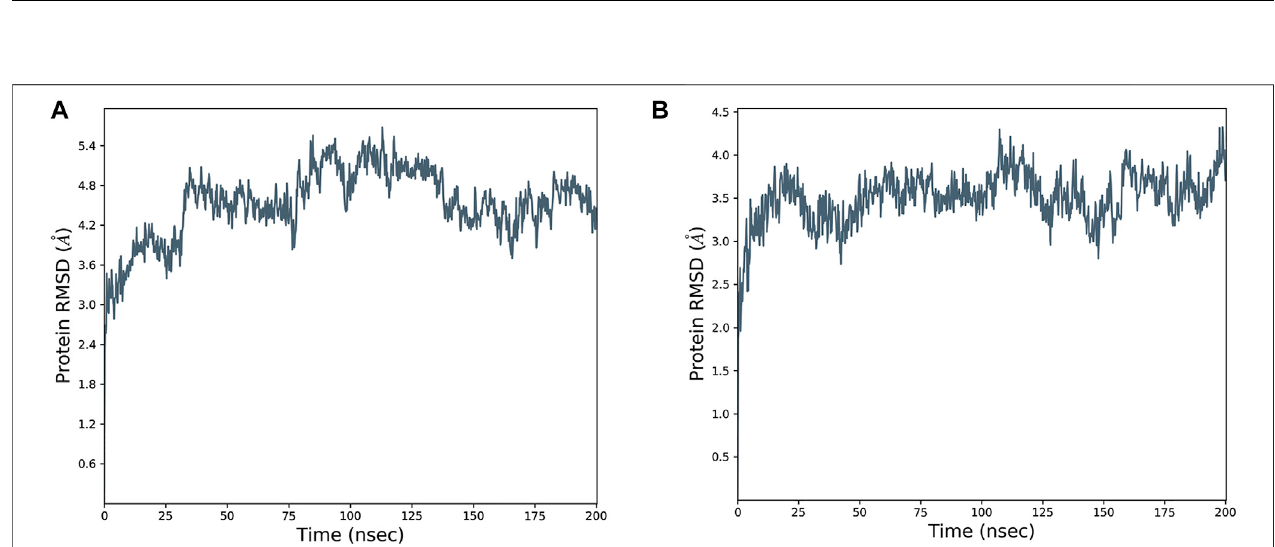
FIGURE 13 | The RMSD (root-mean-square deviation) plot of ANAC019 (A) and ItfNAC62 (B) proteins for 200 ns.